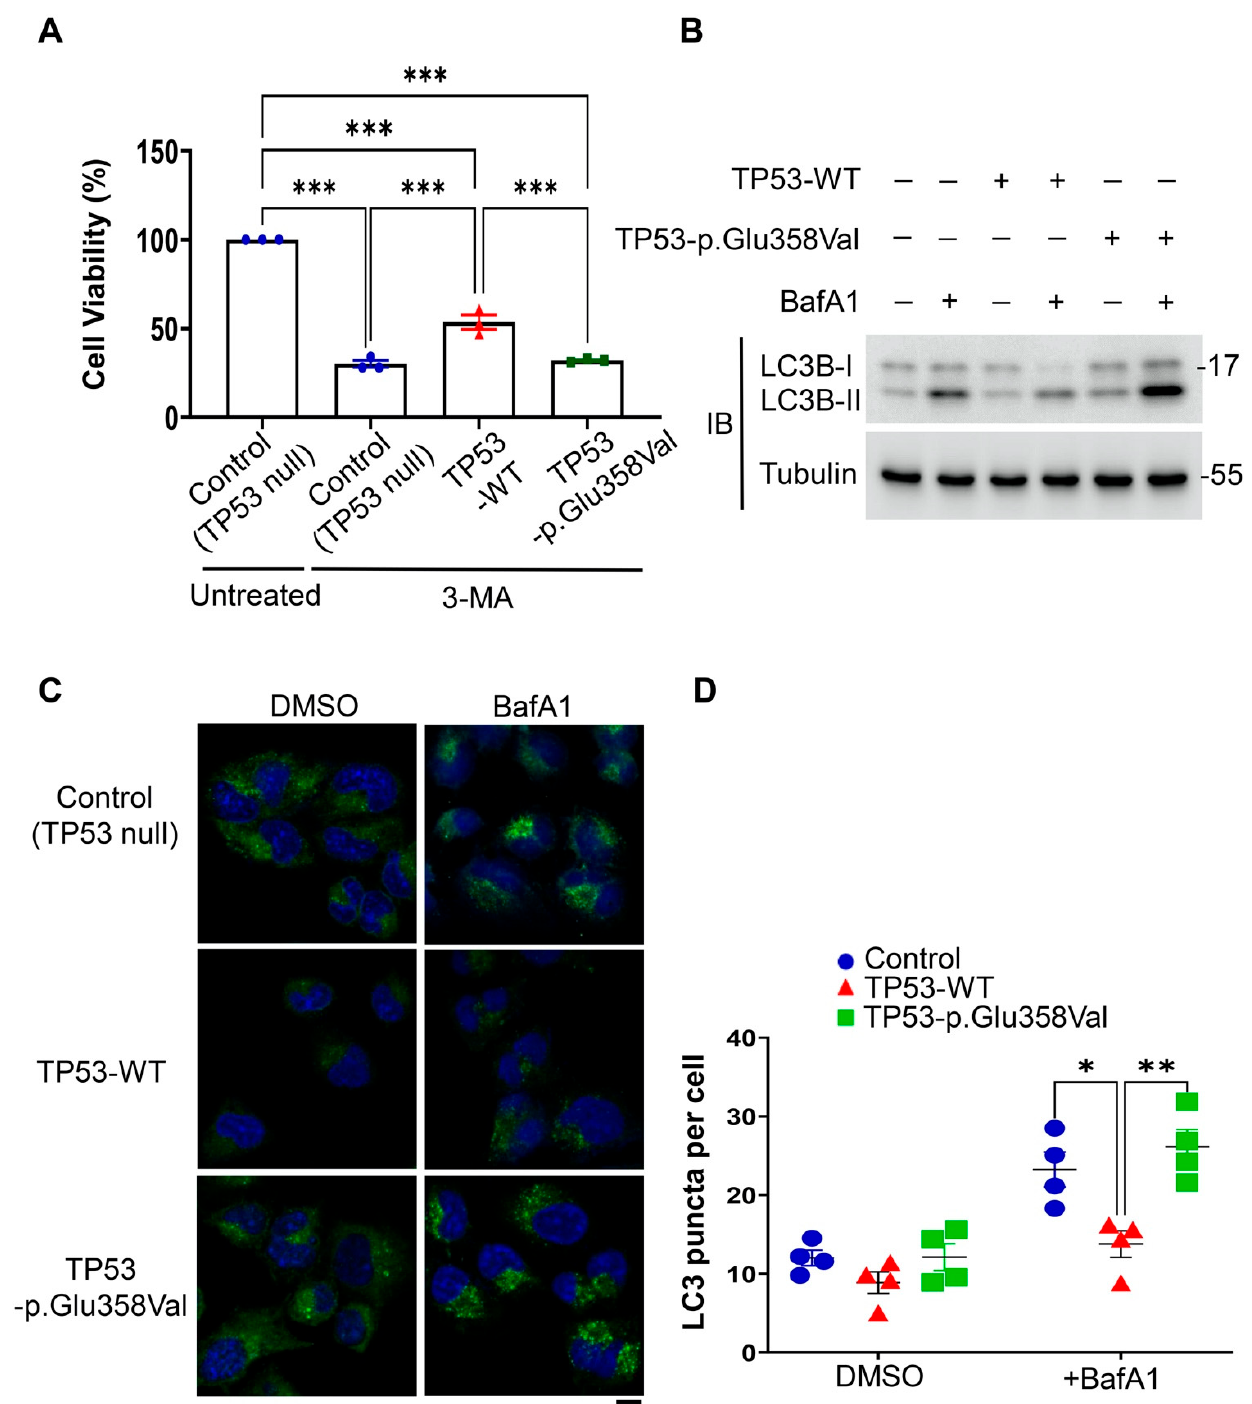
Figure 5. TP53-p.Glu358Val-expressing H2172 cells activate autophagy to sustain NSCLC. ( A ) Cell viabilities after 3-MA treatment. ( B ) Immunoblots of LC3B and tubulin proteins. ( C ) Immunofluorescence of LC3B punctate with or without BafA1 treatment. ( D ) Quantification of LC3 puncta per cell. Scale bar = 10 µm. * p < 0.05, ** p < 0.01, *** p < 0.001.